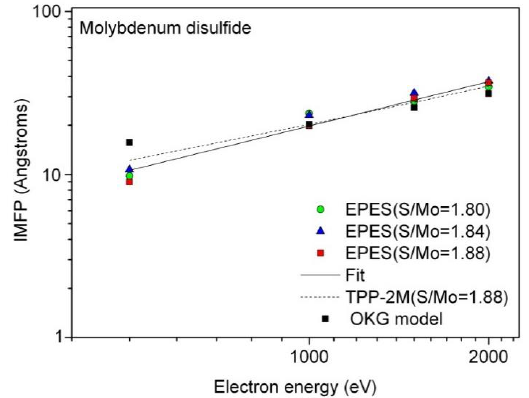
Figure 4. Energy dependence of the inelastic mean free path (IMFP) determined using the Au standard for the Mo 0.357 S 0.643 (open circles, S/Mo = 1.8), Mo 0.315 S 0.581 C 0.104 (open triangles, S/Mo = 1.84) and Mo 0.293 S 0.551 C 0.156 (open squares, S/Mo = 1.88) surfaces. The solid squares indicate the IMFPs calculated